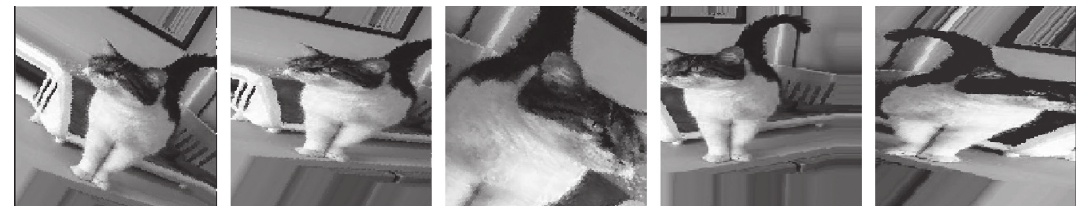
Figure 6: Data augmentation of a single image. (a) Original image. (b) Rescale. (c) Height shift augmentation. (e) Width shift augmentation.